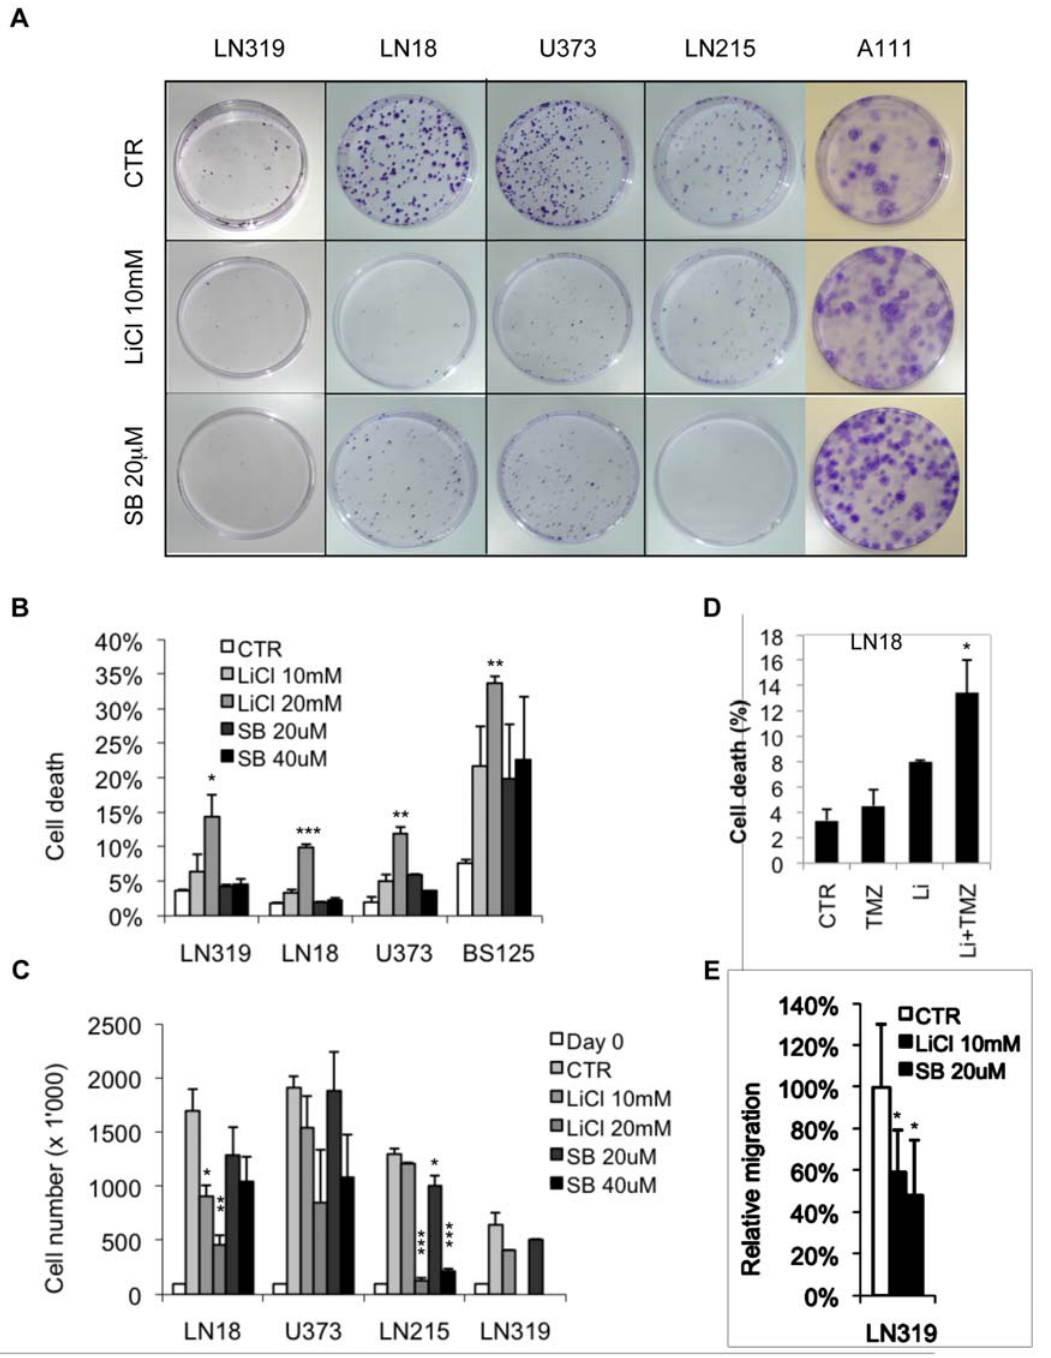
Figure 7. GSK3 b inhibition reduced colony formation of GBM cells. (A) A colony formation assay was performed on GBM cell lines treated with 10 mM LiCl or 20 m M SB216763 for 14 days. (B, C) GBM cell lines treated with LiCl or SB216763 for 72 h. (B) Percent cell death and (C) relative cell number relative to the initial seeding. (D) Cell death determined by PI staining of the LN18 cell line after treatment with 10 mM LiCl with or without 50 m g/ml temozolomide (TMZ) for 72 h. * P , 0.05, for the combination of LiCl and TMZ compared with each drug alone. (E) GSK3 b inhibition significantly reduced migration of the LN319 cell line. (B, C and E) Treated samples were compared to the corresponding control: * P , 0.05; ** P , 0.01; *** P , 0.001; one-way ANOVA (Newman-Keuls Multiple Comparison